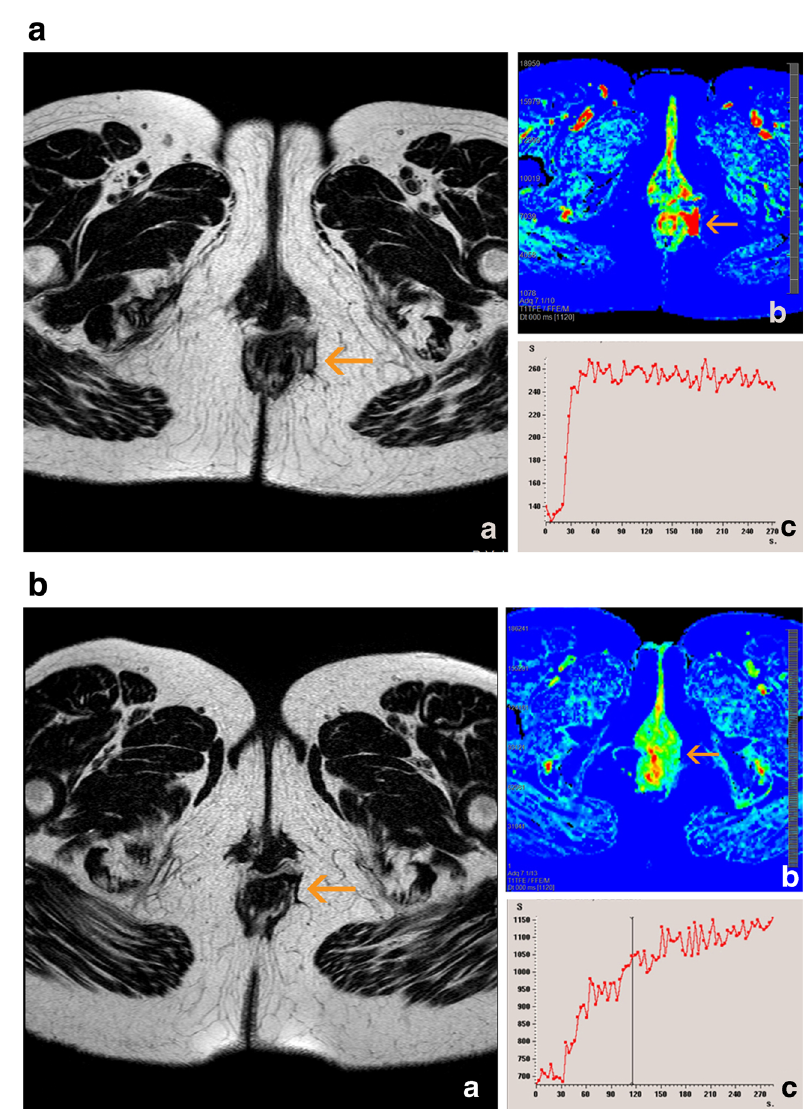
Fig. 11 Effect of treatment on semiquantitative perfusion parameters. a Variation of the maximum relative enhancement at baseline. b Variation of the maximum relative enhancement